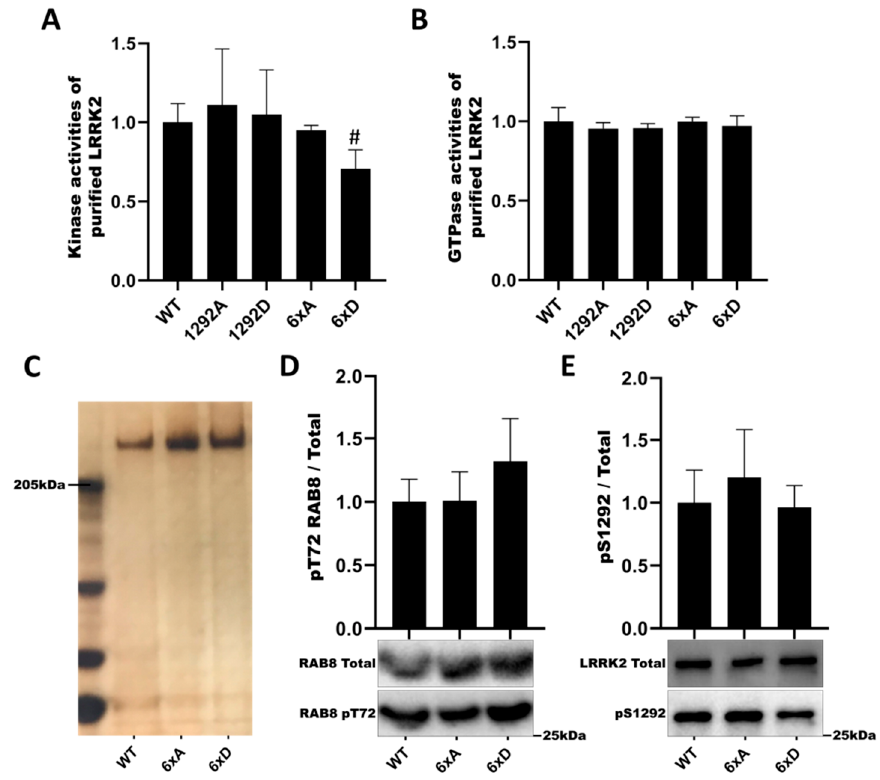
Figure 4. Catalytic activities of LRRK2 phosphorylation mutants. The kinase activities of purified LRRK2 were measured by addition of 32P- γ -ATP and LRRKtide for 30 mn ( A ) and the GTPase activities were measured independently by addition of 32P- γ -GTP for 180 mn ( B ) and then quenched. Samples were assay using scintillation counting. ( C ) Silver staining of purified LRRK2 proteins. ( D ) Purified proteins are incubated with recombinant RAB8a (Life technologies) and ATP for 60 min. Measurement of LRRK2 autophosphorylation level pS1292-LRRK2 ( D ) and level of RAB8a phosphorylation pT72-RAB8a ( E ). The data represent the mean ± SEM from three independent experiments and analyzed by Kruskal–Wallis test followed by a Dunn’s test using the WT condition as control. (# p = 0.0549).